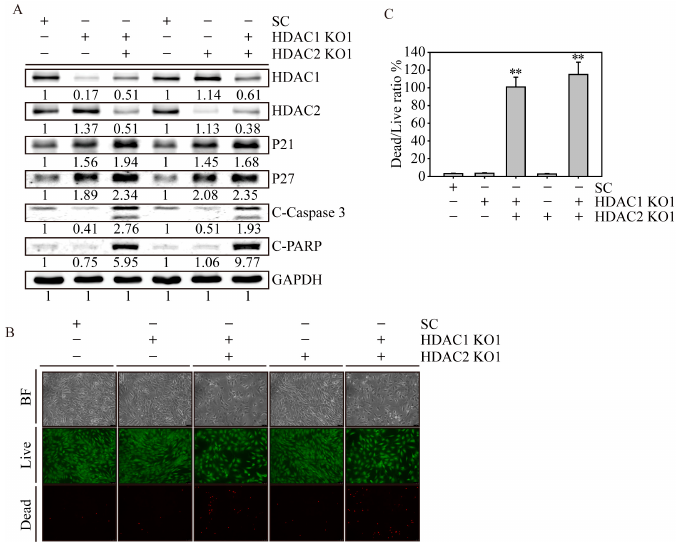
Figure 6. HDAC1 and HDAC2 double knockout SW579 cells induced cell cycle arrest and apoptosis. ( A ) Immunoblot analysis of protein expression in SC, HDAC1 , HDAC2 and HDAC1 , 2 KO SW579 cells. The cell lysate was analyzed for HDAC1 and HDAC2 expression and cell cycle (p21 and p27) and apoptosis-related (C-Caspase 3: cleaved caspase 3 and C-PARP: cleaved PARP) protein expression. GAPDH immunoblots served as internal controls. Densitometric analysis of all western-blot was performed by ImageJ software. The protein expressions were normalized with their internal control such as H3, H4 or GAPDH expressions and shown as fold of control. ( B ) Live/dead cell viability assay of SC, HDAC1 , HDAC2 and HDAC1 , 2 KO SW579 cells. The cells were costained with 1 µM calcein-AM and 10 µM PI and live/dead cells were analyzed using fluorescence microscopy. The viable cells showed green fluorescence with light emission at a wavelength of 488 nm, whereas the dead cells showed red fluorescence in the nucleus with light emission at a wavelength of 532 nm. The brightfield images show the morphology of gene-edited SW579 cells. Scale bar represents 10 µm, and the magnification is 100×. ( C ) The dead/live cell ratio of gene-edited SW579 cells. Data are presented as the mean and standard deviation. Data were analyzed with Student’s t -test and all p -values were two-sided. p -values less than 0.01 are indicated with two asterisks.